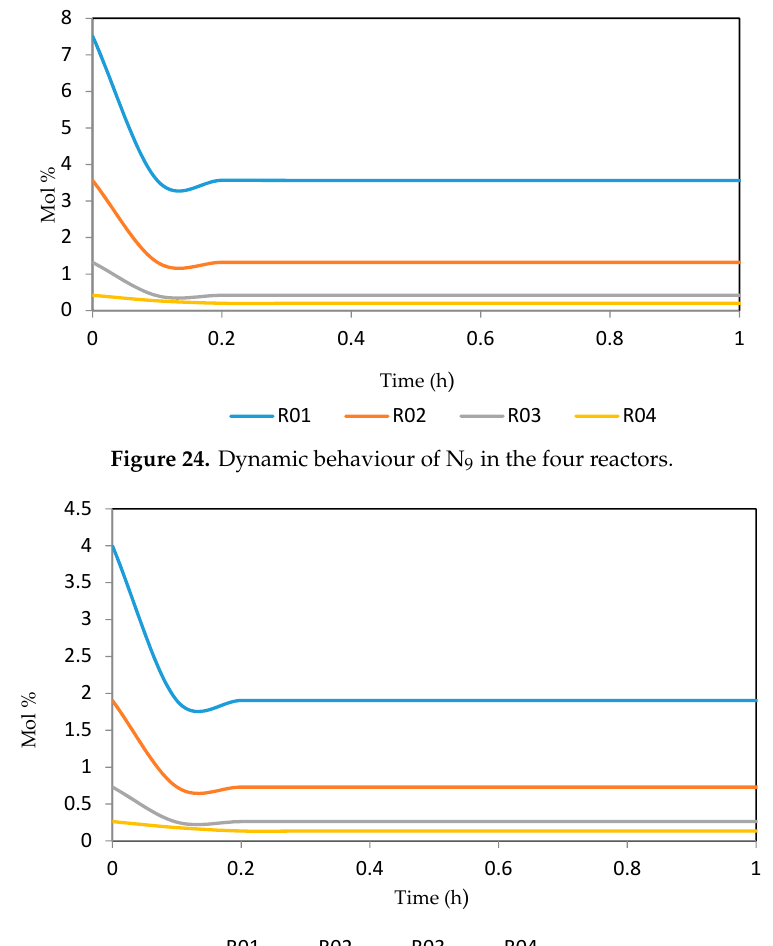
Figure 23. Dynamic behaviour of N 8 in the four reactors.